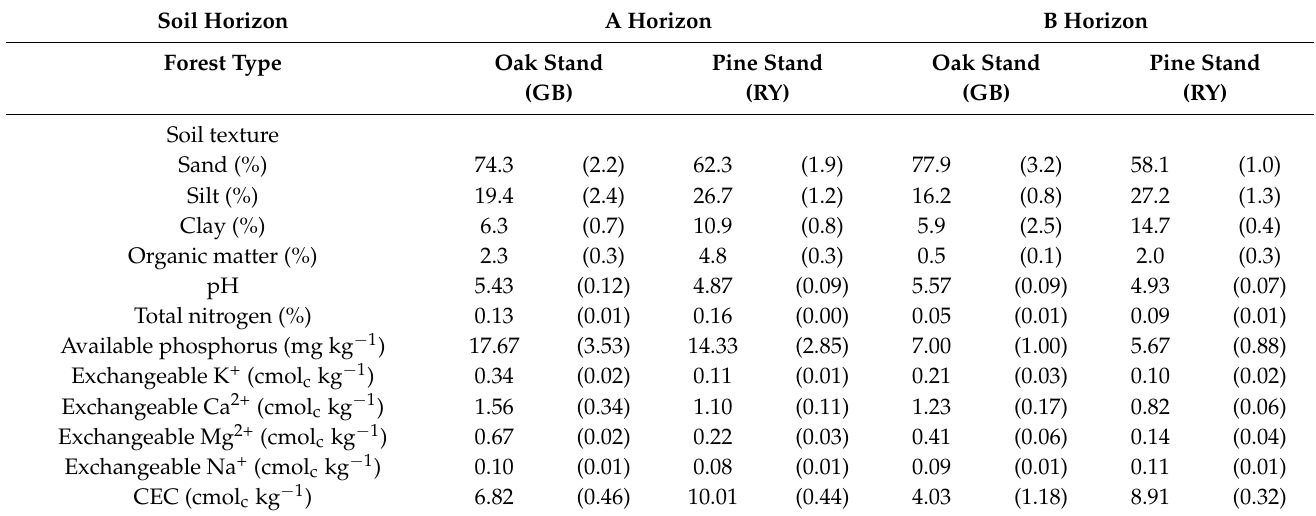
Table 1. Soil properties from oak and pine stands. Parentheses are standard errors of the mean ( n = 5).